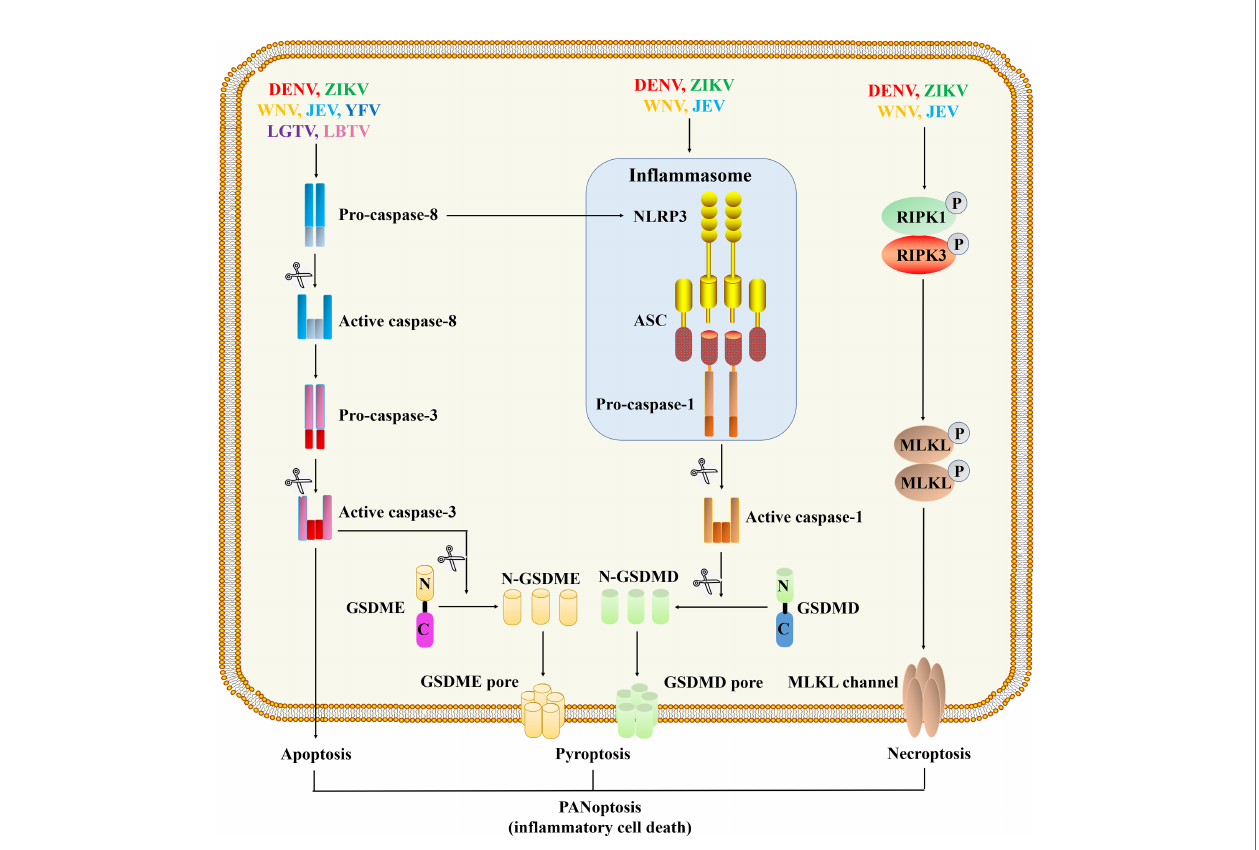
FIGURE 4 | Programmed cell death pathways during fl avivirus infection. The viral proteins of DENV (88 – 90), WNV (91), ZIKA (92, 93) and JEV (94) can act as cytoplasmic PAMPs to stimulate the assembly of in fl ammasomes, thereby activating caspase-1. Activated caspase-1 cleaves GSDMD, and then the N-terminal fragment of GSDMD oligomerizes in the membrane to form membrane pores and initiate pyroptosis. Flavivirus infections also initiate a signal cascade mediated by caspase-8, activated caspase-8 cleaves and activates caspase-3 to initiate apoptosis (95 – 98). WNV (68), ZIKA (99, 100) and JEV (101) infections can trigger necroptosis, which depends on the formation of RIPK1 and RIPK3 complexes and the activation of downstream MLKL proteins to form channels in the